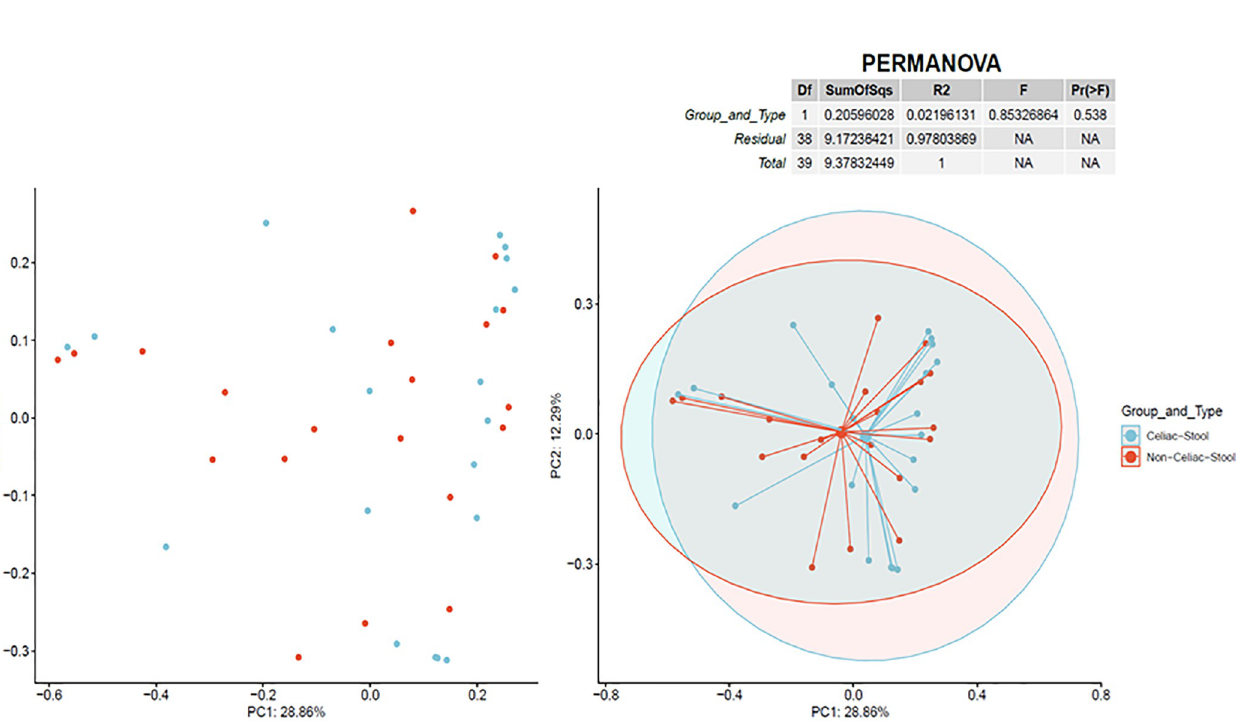
Fig 4. Bray-Curtis beta diversity in stools. Two-dimensional principal coordinate analysis for viral species in stool samples showing almost complete overlap of CeD samples celiac (CeD) and non-CeD samples. The right plot overlays a 95% confidence ellipse over each cohort and lines connect all values to the average of the